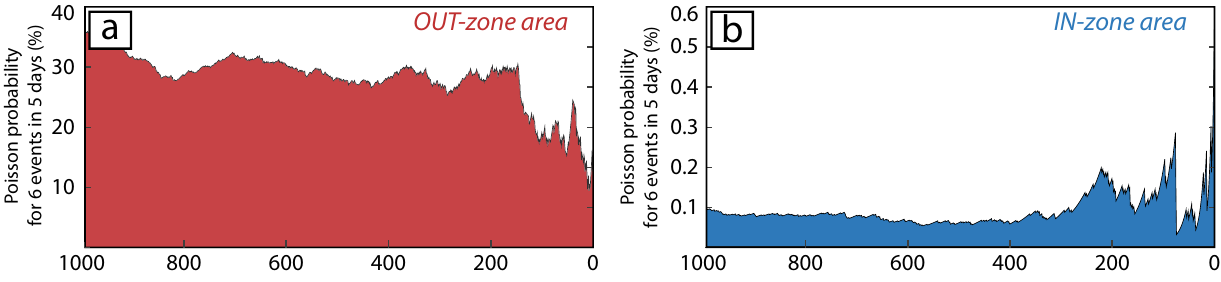
Figure 3. Poisson probability based on the frequency of earthquake occurrence. Probability that six earthquakes occurred in a time period of 5 days before the Maule main shock (see Fig. 5a), considering a time distribution of the events following a Poisson’s law. ( a ) Results using the OUT-zone region dataset, ranging from 20 to 35% that such a case happen. ( b ) Results using only events distributed within the IN-zone. In this case, there is only 0.1–0.3% that six earthquakes occur in 5 days within the IN-zone for all the time period